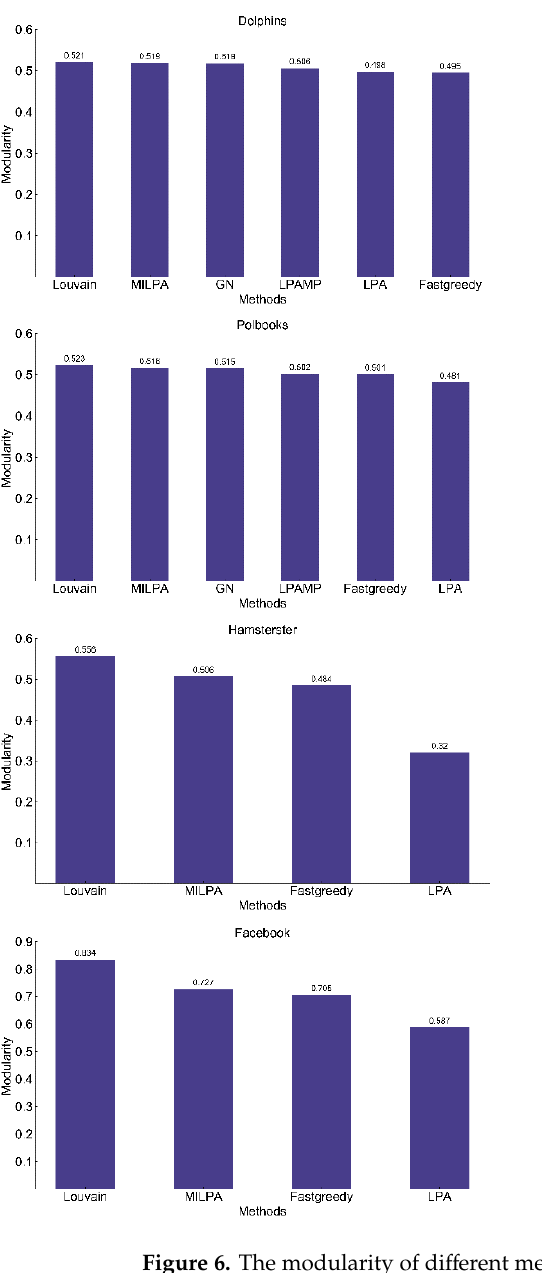
Figure 6. The modularity of different methods in eight real-world networks.